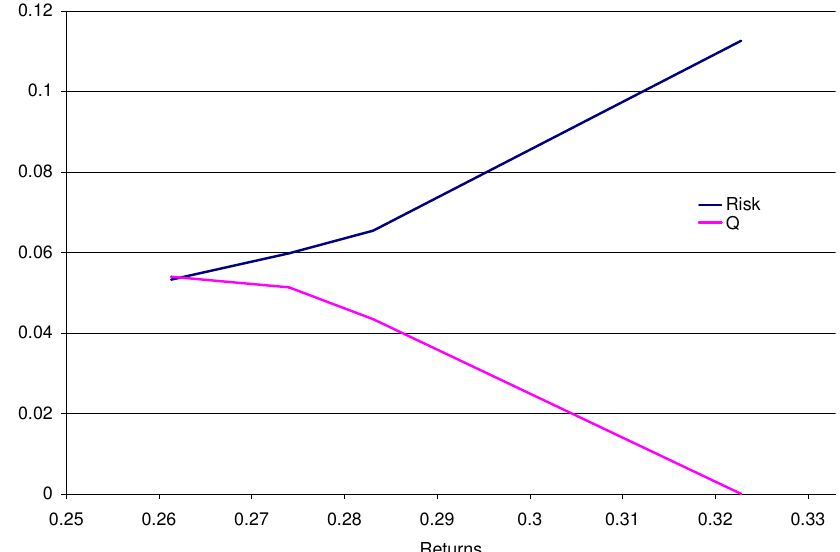
Figure 3: Solutions to the multiple objective problem (6) with w proportion of carrying capacity (food resources) allocated to any species. The risk associated with each solution is given, but risk was omitted from the objective